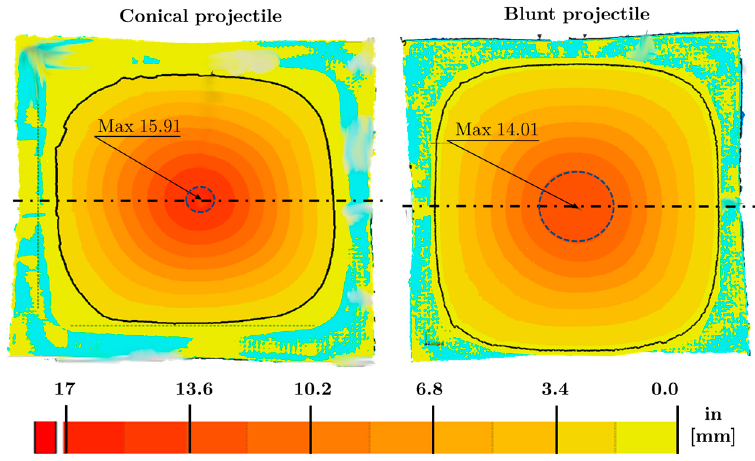
Figure 11. Impact direction displacement map. ( left ) Conical and ( right ) blunt projectile (V o = 174 m/s).